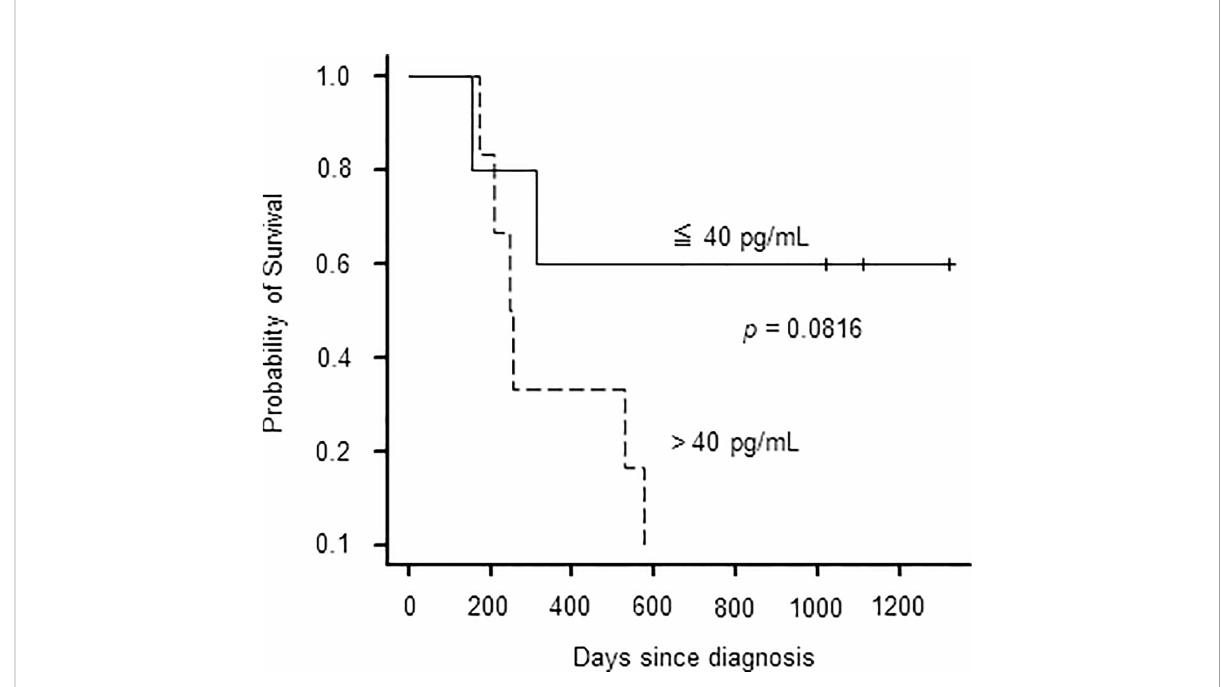
FIGURE 3 The probability of survival of sCAEBV patients by plasma concentration of IFN- g